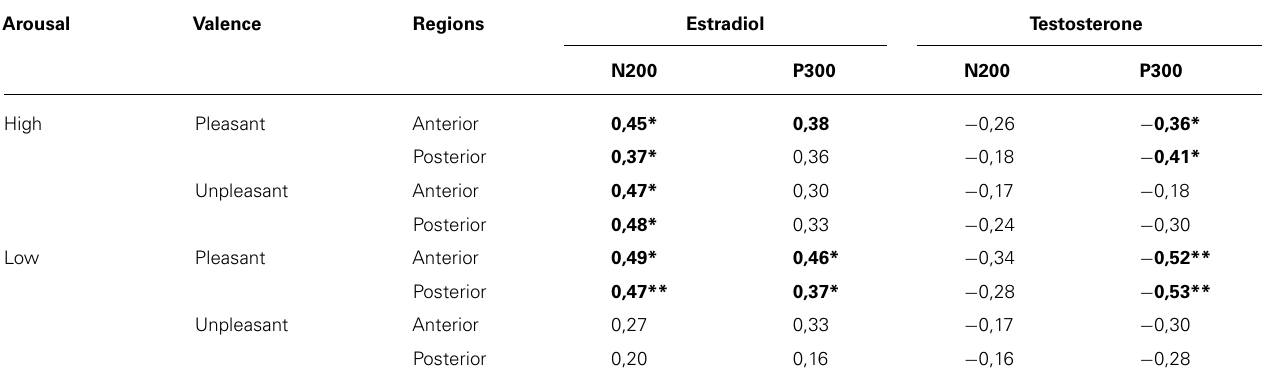
Table 5 | Correlations between gonadal hormones and N200/P300 amplitude in response to arousal and valence conditions across regions (control group). Arousal Valence Regions